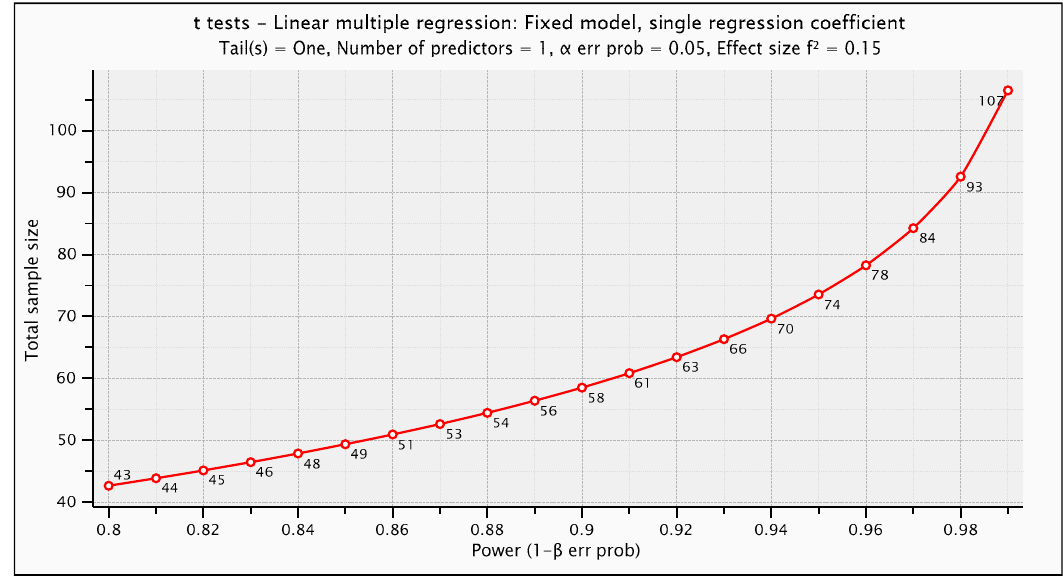
Figure 2. Results of a priori power analysis.